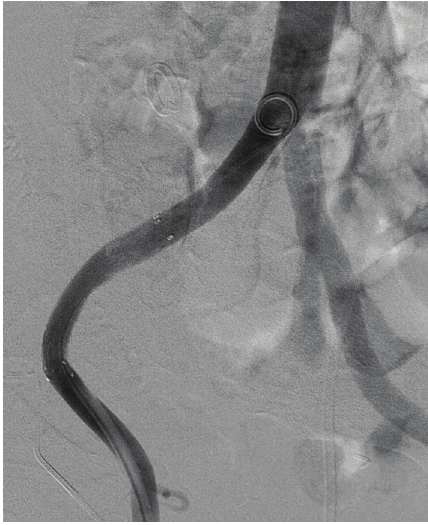
Figure 3: A covered stent securely placed in the right common and external iliac